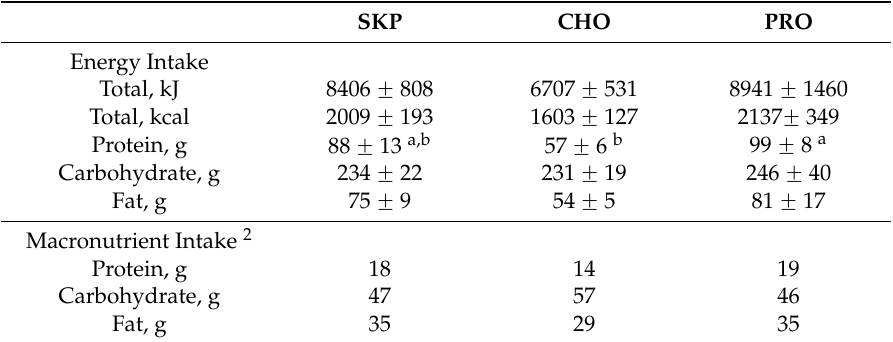
Table 3. Average daily energy and macronutrient intake during adaptation period 1 .